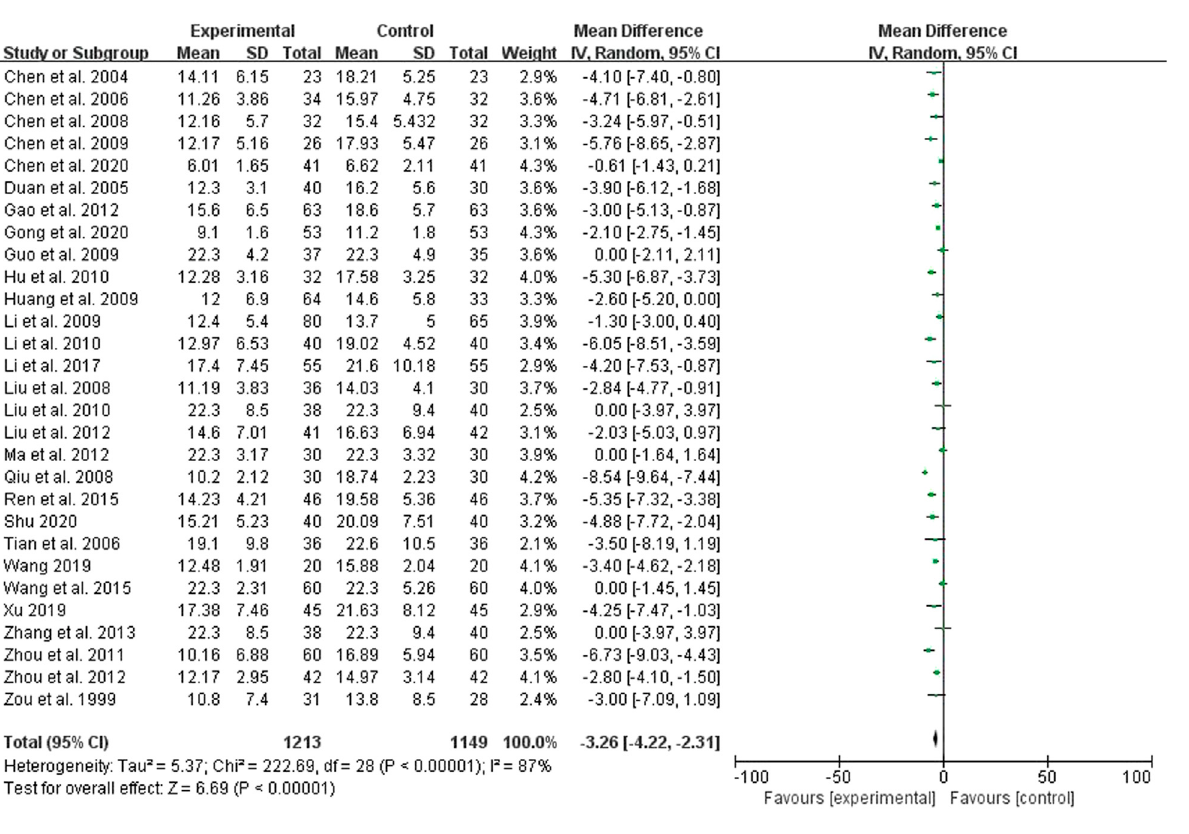
FIGURE 3 Forest plots showing MD (with 95% CI) for BUN comparing Rhubarb with the usual